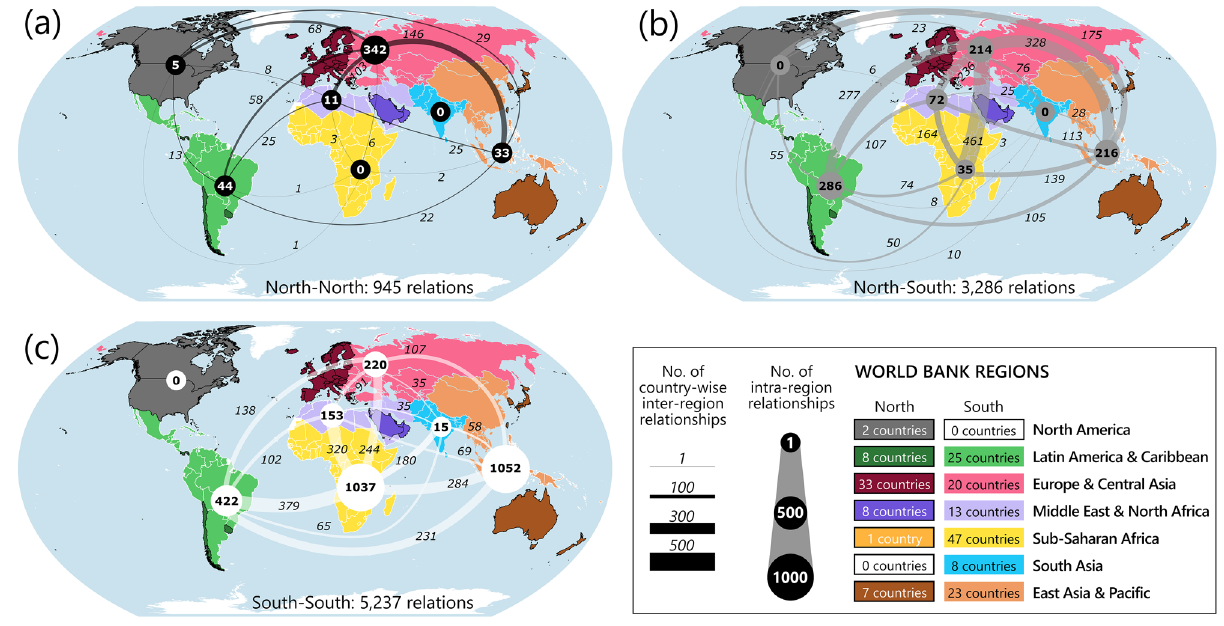
Figure 5. Number of country-wise relationships within and between World Bank regions. The types of relationships are indicated by different coloured circles (within regions) and lines (between regions): ( a ) North– North relationships (black), ( b ) North–South relationships (grey) and ( c ) South-South relationships (white). The size of circles and the figures in the circles represent the number of relationships between partners from different countries within each region. Line thickness and the figures in italics associated with the lines represent the number of relationships between partners from different regions. Numbers in the coloured boxes of the legend identify the respective numbers of Northern countries and Southern countries in each region included in the analysis. Maps generated in Arcgis Desktop 10.7 (https:// www. esri. com/ en- us/ arcgis/ produ cts/ arcgis- deskt op/ overv iew) and further modified in Inkscape 0.92.5 (https:// inksc ape. org/). Larger versions of the components of this figure are included in Supplementary